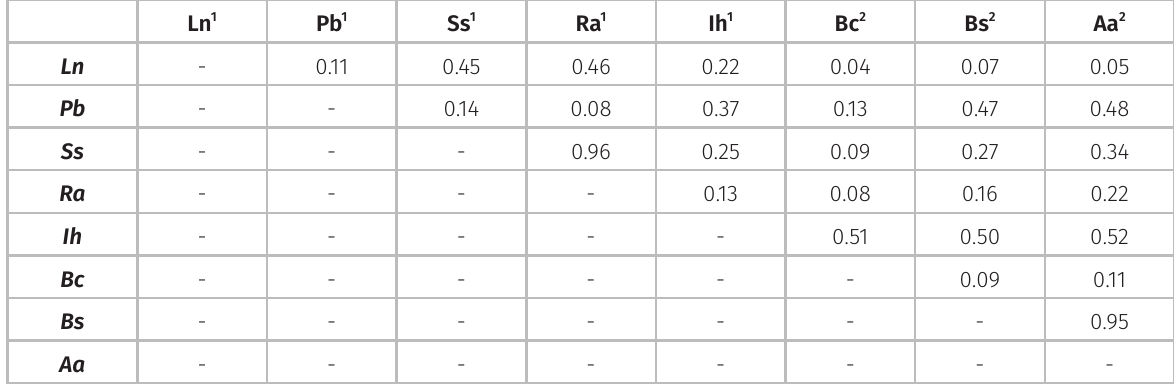
Table IV. Overlap of trophic niche among the species evaluated (O Pb = Proceratophrys boiei , Ss = Scythrophrys sawayae , Ra = Rhinella abei , Ih = Ischnocnema henselii , Bc = Bokermannohyla circumdata , Bs = Boana semiguttata , Aa = Aplastodiscus albosignatus . 1 species of terrestrial habit; 2 species of tree